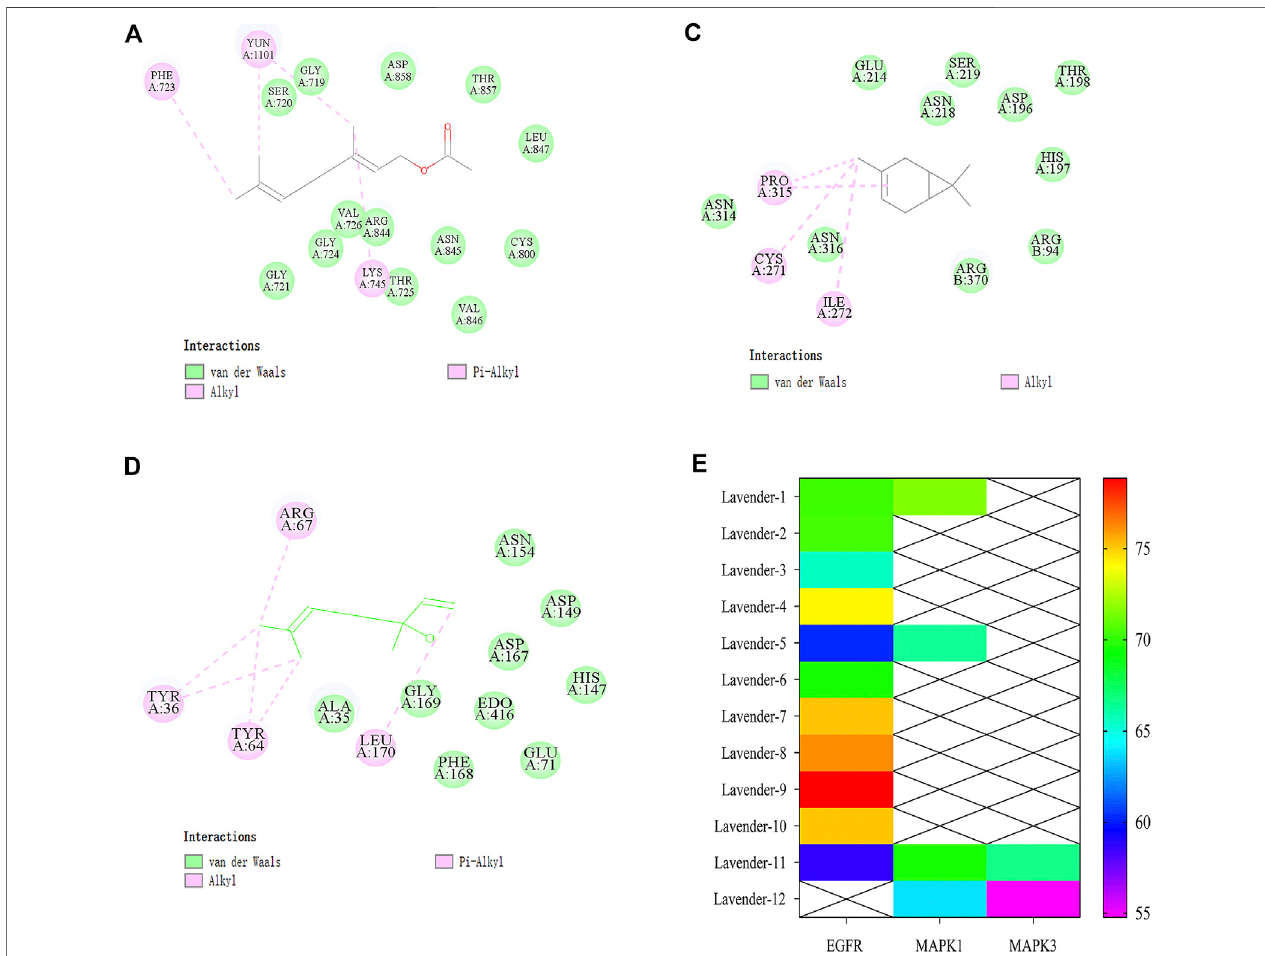
FIGURE 4 | Docking of lavender active components with key